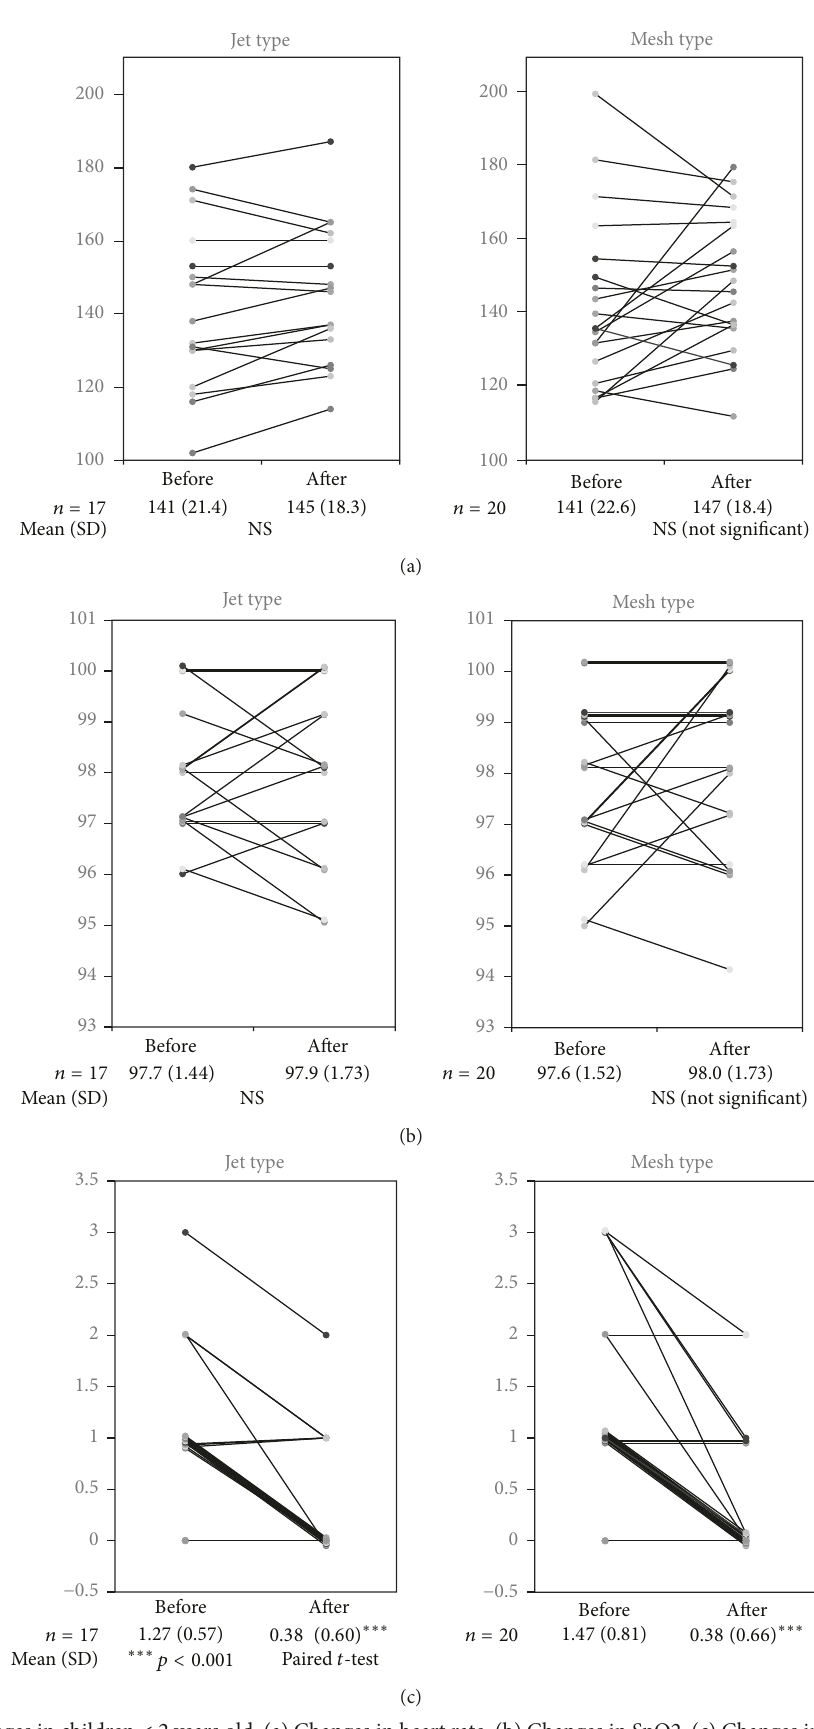
Figure 2: Changes in children < 2 years old. (a) Changes in heart rate. (b) Changes in SpO2. (c) Changes in symptom